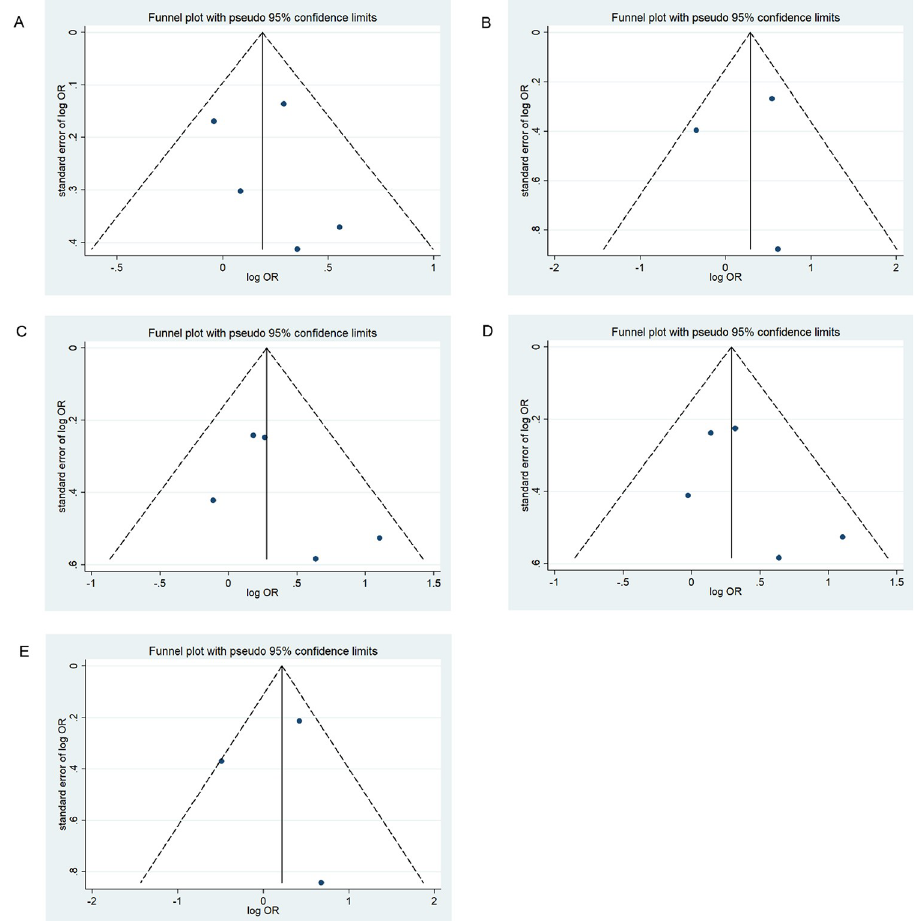
Fig 9. Funnel plot analysis depicting publication bias in the association between MTHFR 1298A > C polymorphism and ADHD in the five genetic models (A, allele contrast; B, homozygous codominant; C, heterozygous codominant; D, dominant; and E,